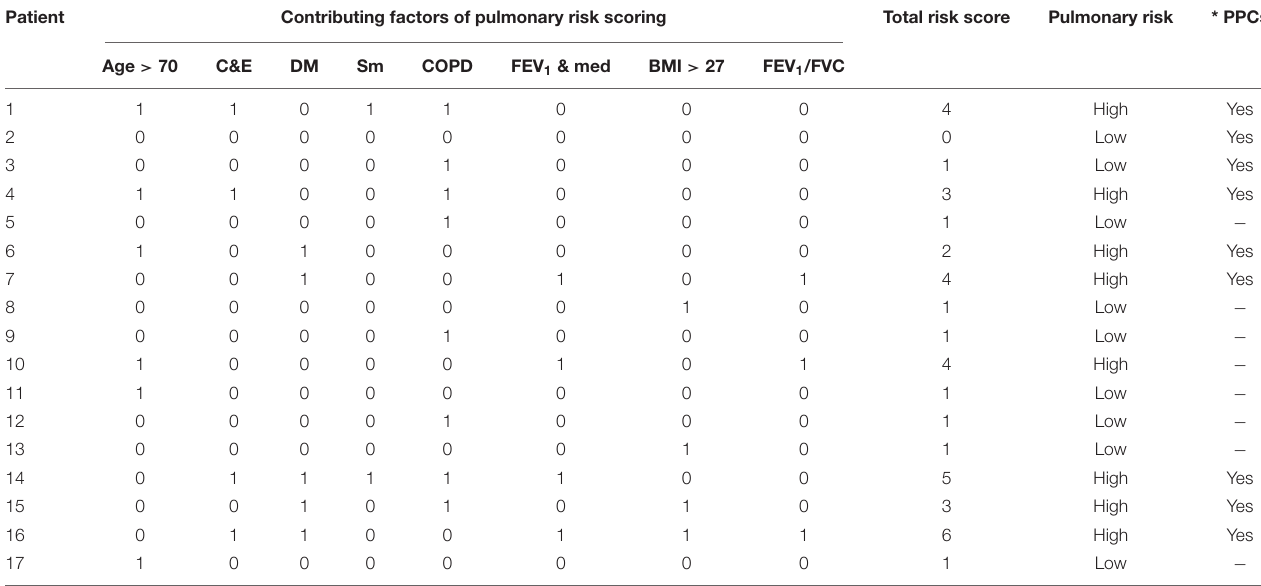
TABLE 2 | Scoring of pre-operative pulmonary risk assessment in the 17 patients consented for surgery. Patient Contributing factors of pulmonary risk scoring Total risk score Pulmonary risk